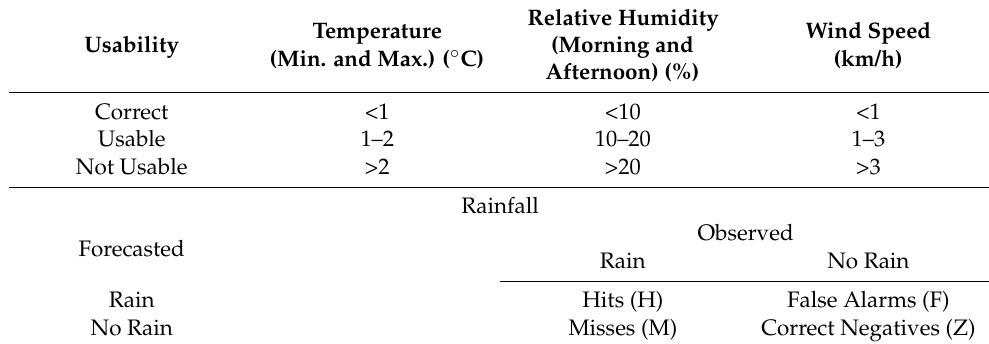
Table 2. Error structure for the verification of the accuracy of different weather parameters in this study in the northeastern hill region of